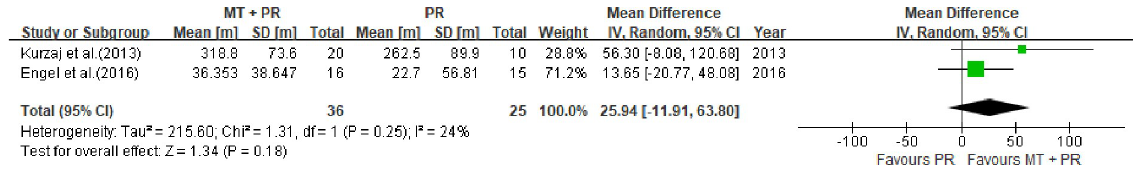
Fig 7. Forest plots for comparison of 6-minute walk distance (6MWD) between manual therapy (MT) plus pulmonary rehabilitation (PR) and PR